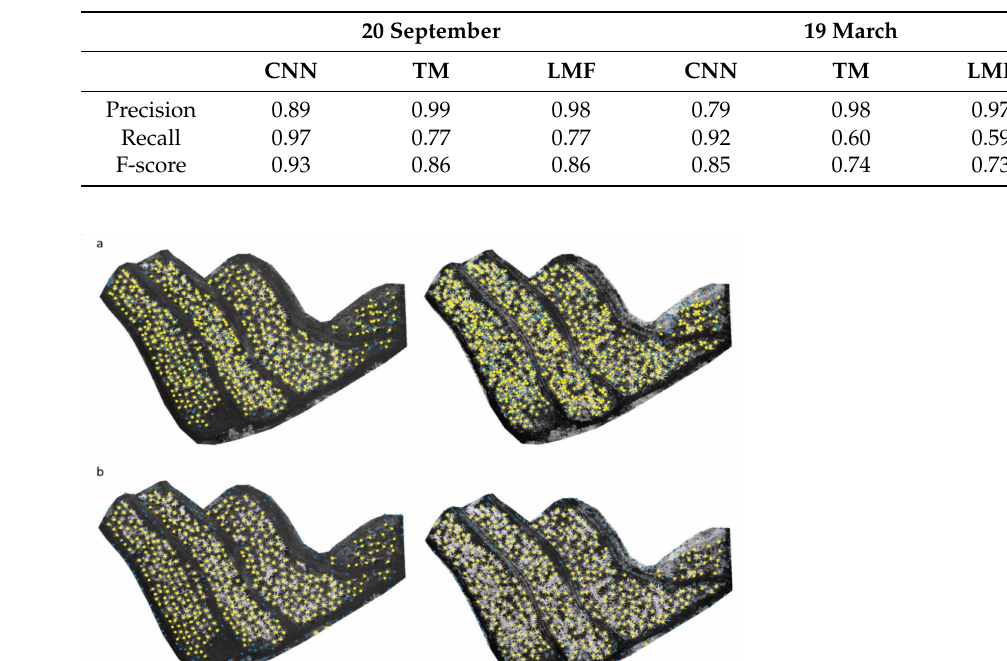
Table 3. Precision and recall results following classification refinement.